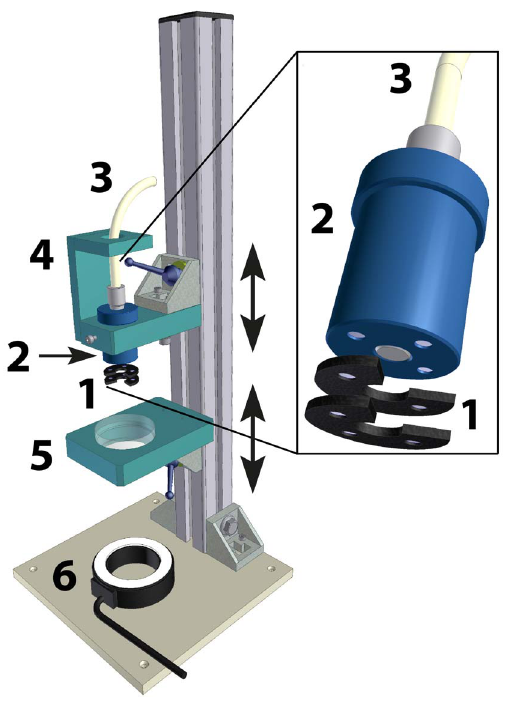
Figure 2. PAM fluoroscope used for NIFT experiments. PAM fluoroscope, consisting of (1) two L magnetic rings for proper sample placement in front of PAM sensor; (2) magnetic PAM sensor head; (3) PAM sensor; (4) adjustable holder for placement of PAM sensor; (5) adjustable Petri dish holder; (6) LED-light with adjustable light intensity.